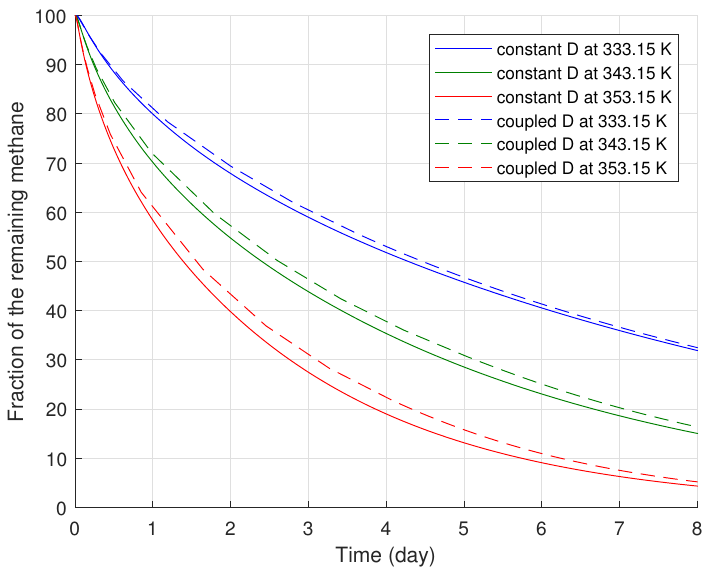
Figure 7. Degassing efficiency between constant and coupled diffusion cases with various degassing temperatures, 333.15, 343.15, and 353.15 K (equivalent to 60, 70, and 80 ◦ C,